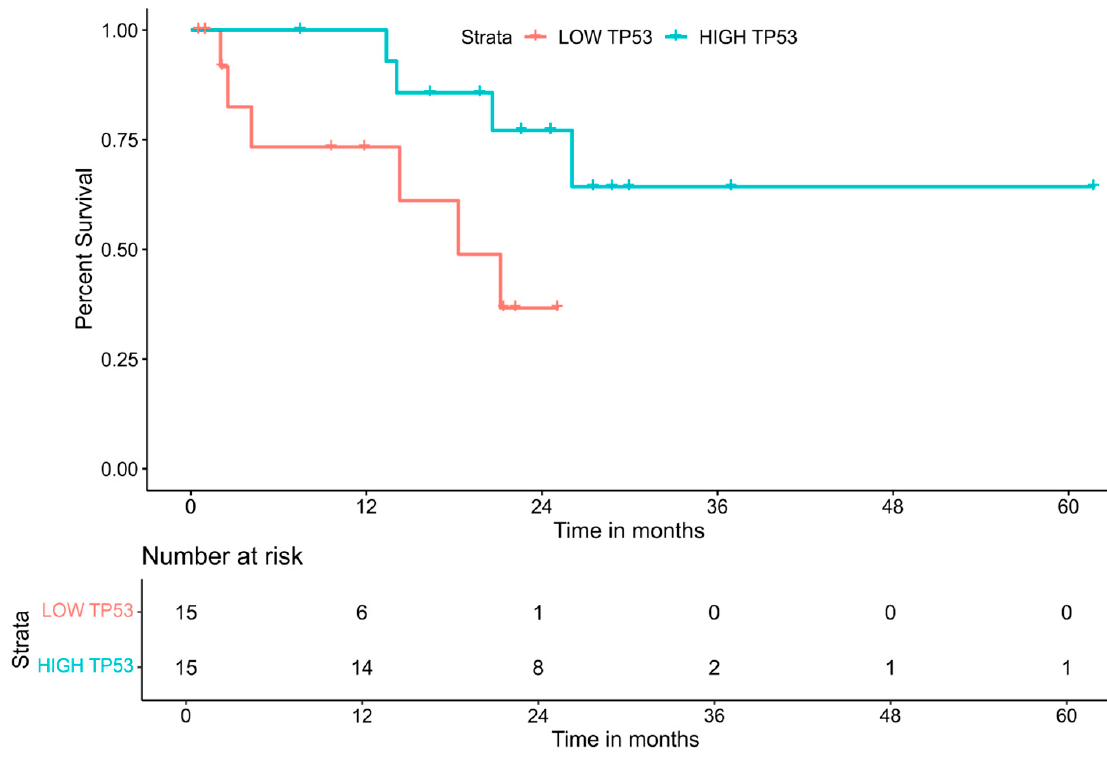
Figure 2. Sample Kaplan–Meier survival curve for p53 (Gene ID: 7157) in the EBVaGC subset of the TCGA STAD cohort. This figure was generated natively by the mRNA version of the overall patient survival tools in the EBV-GCR web suite. The samples are divided into equally sized subsets of high and low expressions of TP53 transcripts at the median level of expression for TP53 .